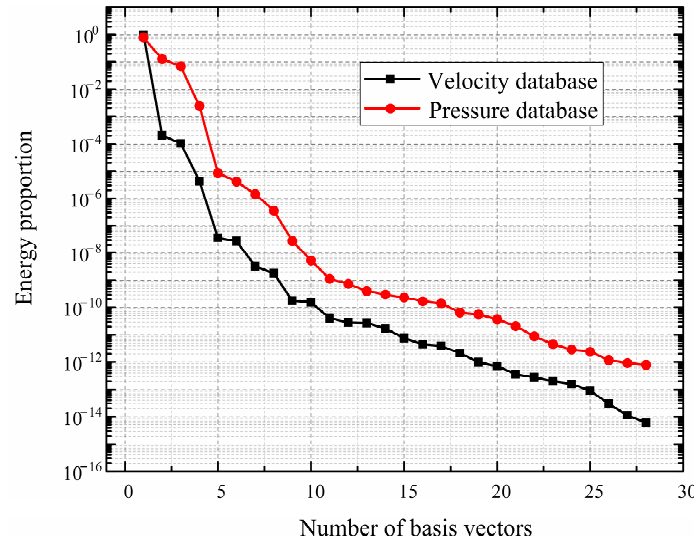
Figure 8. The “energy proportion” of each eigenvalue in all eigenvalues. Finally, by exploring the influence of different noise levels and the number of basis vectors on the reconstruction error, the optimal number of basis vectors is determined for reconstruction calculation. This section increases the noise level from 1% to 30% with an interval of 1%. Referring to Figures 7 and 8, the number of eigenvectors of the velocity field is set to 2, 4, 6, 8 and 10, and the number of eigenvectors of the pressure field is set to 8, 9, 10, 11 and 12. With a fixed number of sensors and arrangement, the corresponding reconstruction error results are shown in Figures 9 and 10.